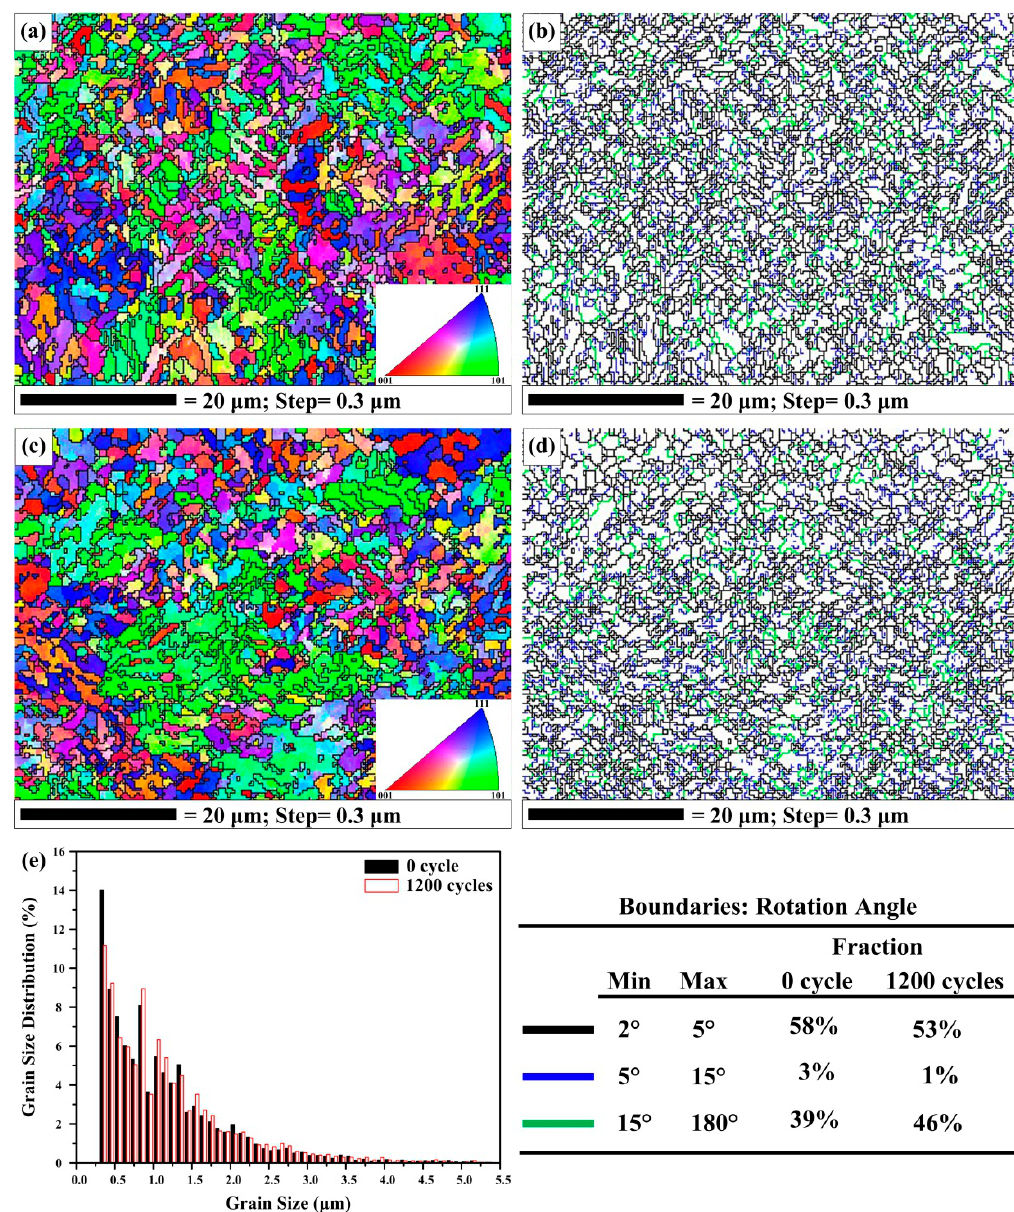
Figure 7. Electron backscatter diffraction (EBSD) orientation map and grain boundary misorientation map of the specimens before and after thermal fatigue test: ( a , b ) 0 cycle, ( c , d ) 1200 cycles, and ( e ) grain size distribution.